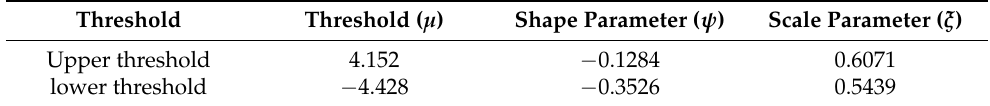
Table 6. Fitting results of GPD distribution parameters for ploughing process